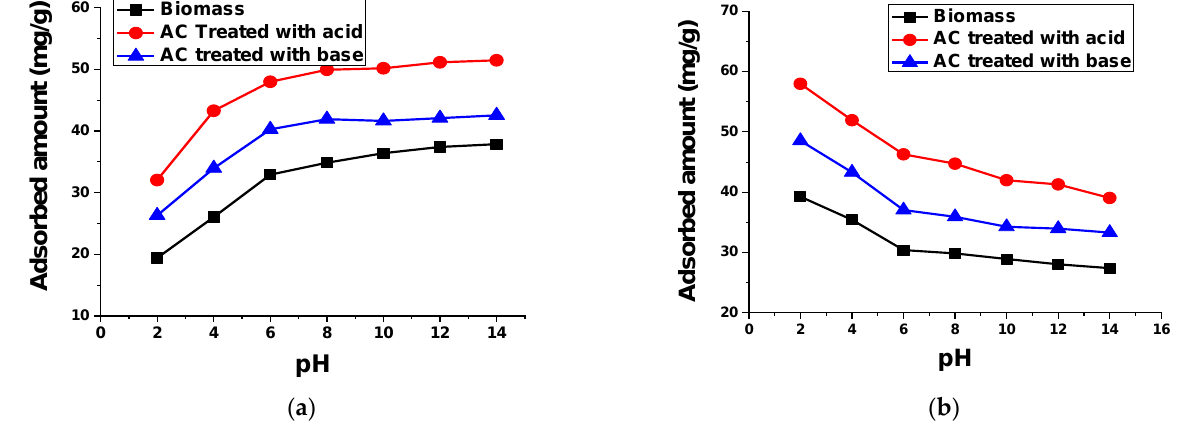
Figure 11. Effect of pH on the adsorption of 50 mL ( a ) 100 mg/L TB and ( b ) 50 mg/L XO using 0.1 g biomass and AC treated with acid and base for 60 min at 140 rpm and room temperature.